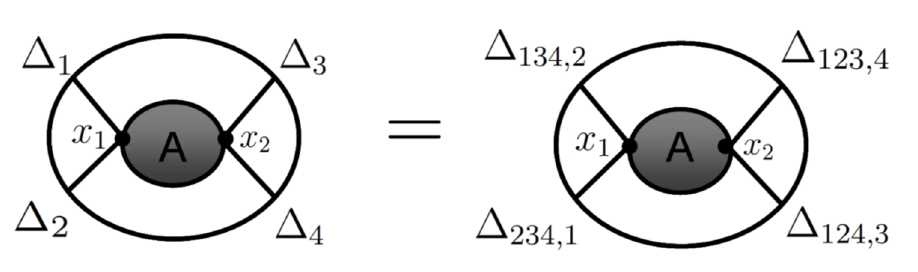
Figure 3 . Identity 1. For every choice of external scaling dimensions (cid:1) i , the 4-point function on the left equals the 4-point function on the right, where we de(cid:12)ne (cid:1) 123 ; 4 (cid:17) (cid:1) 1 +(cid:1) 2 +(cid:1) 3 (cid:0) (cid:1) 4